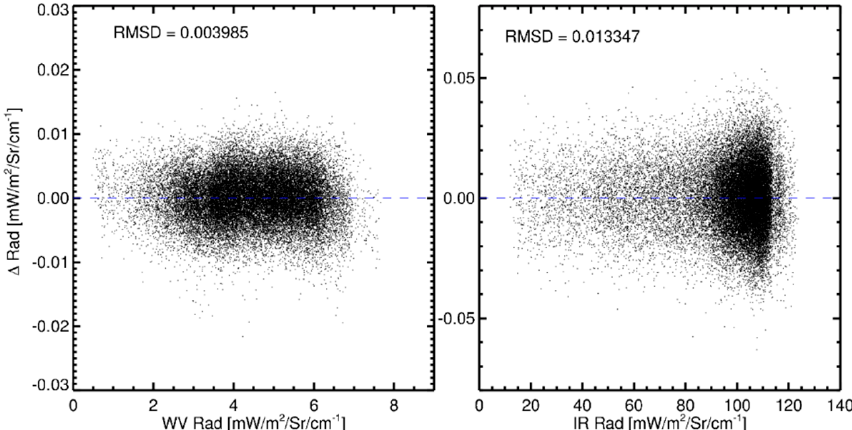
Figure 5. Demonstration of constructing broadband radiances from available AIRS channels. The plots show the difference between the Meteosat-7 radiances computed from available AIRS channels and from the full IASI spectra for the WV (left) and IR (right) channels.